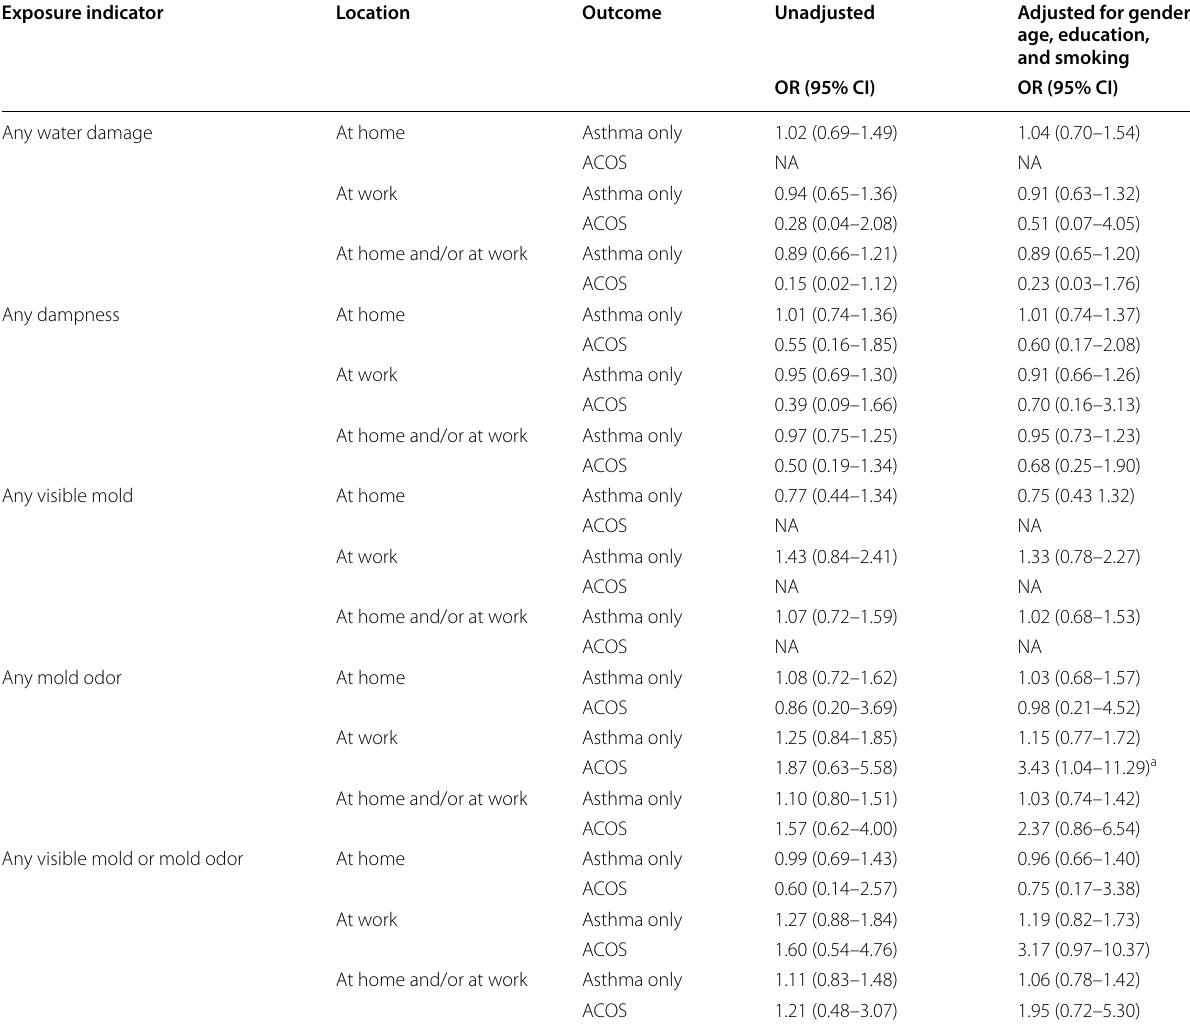
Table 3 The Relation between exposure indicators of indoor dampness and mold problems and the risk of ACOS and asthma only, the Finnish Environment and Asthma